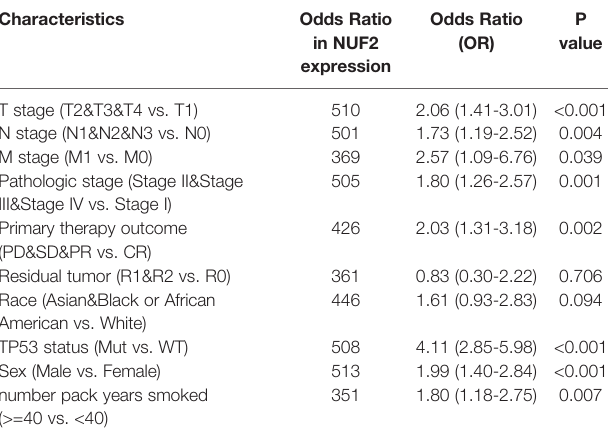
TABLE 3 | Logistic regression analysis between NUF2 expression and clinical features.